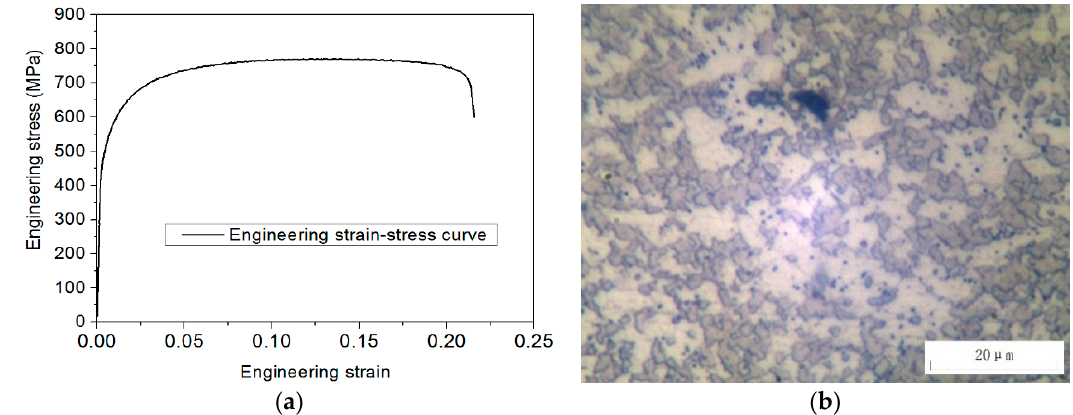
Figure 1. Mechanics and metallographic of DP800 steel. ( a ) The engineering stress ‐ strain curve of DP800. ( b ) The metallograph of DP800.